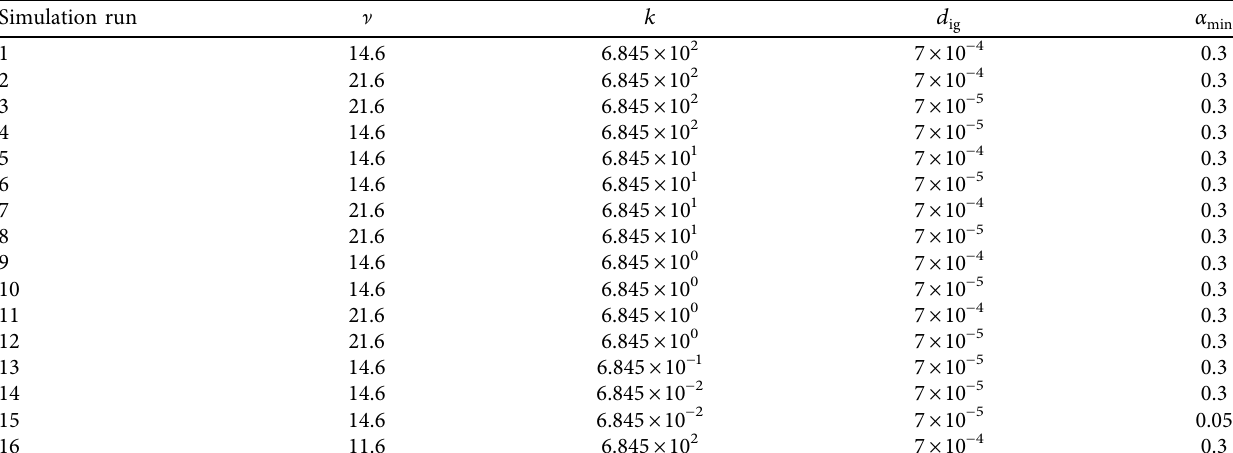
Table 1: Parameter values utilized to carry out numerical simulations. Data refer to variable parameters, namely, the frequency ] (Hz) of the reactor swing, the rate constant k (s − 1 ) of the Johnson-Mehl-Avrami kinetic law, the ignition distance d threshold of conversion degree α min